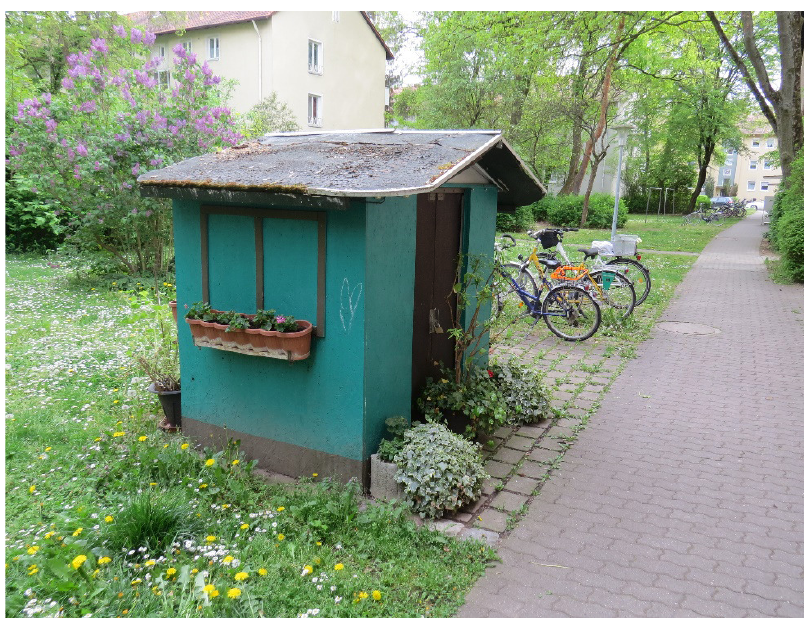
Figure 3. Residents’ creative use of a niche of green space.